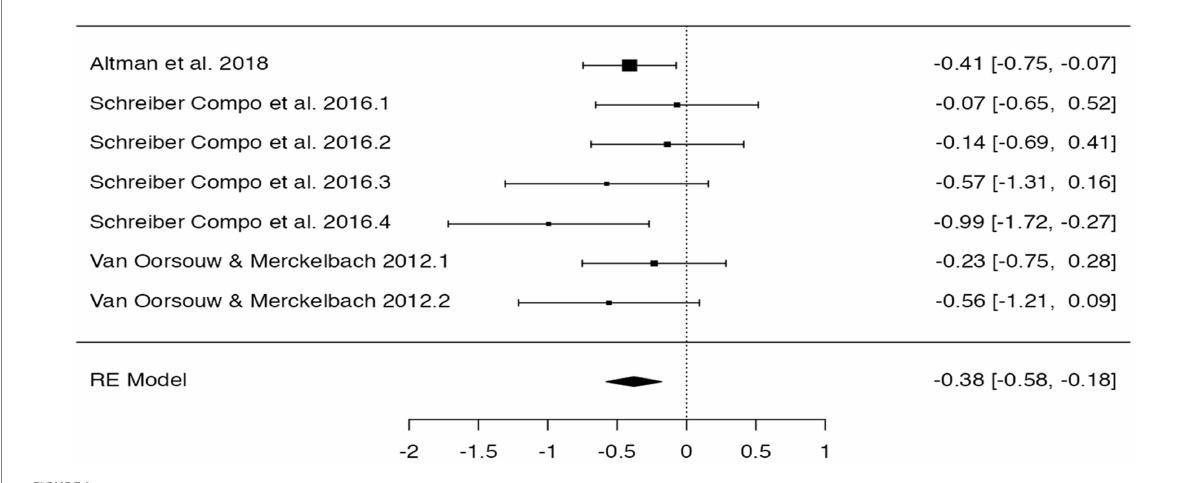
FIGURE 1 Forest plot concerning alcohol intoxication and incorrect details (cued